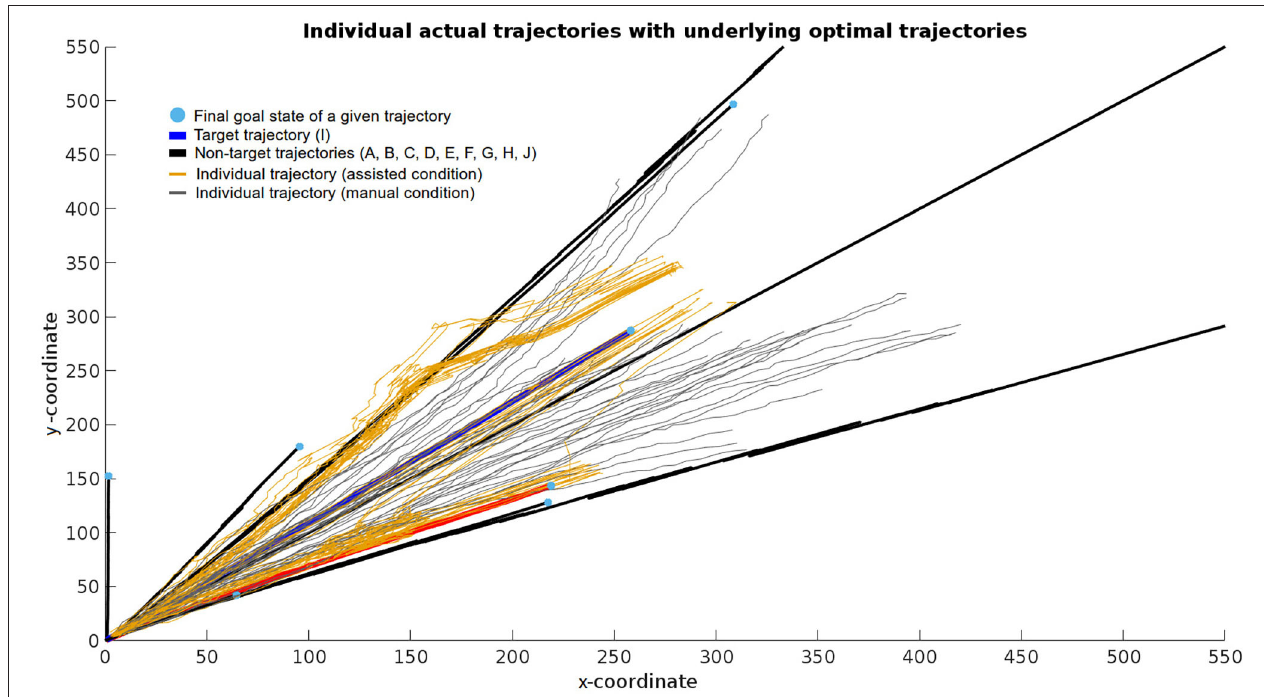
FIGURE 6 | Example data from a series of executions of the manual (gray lines) and assisted (orange lines) condition. Black, red, and blue lines correspond to the optimal trajectories leading to their respective target grasp poses. More specifically, the blue line corresponds to the target trajectory (I), the red line to a neighboring trajectory (F) to which the assisted condition incorrectly converged in some cases, and the black lines to remaining neighboring trajectories. This data displays the starting and ending positions together with the error and dynamics of how the controller handled user input from the beginning until the end of a given